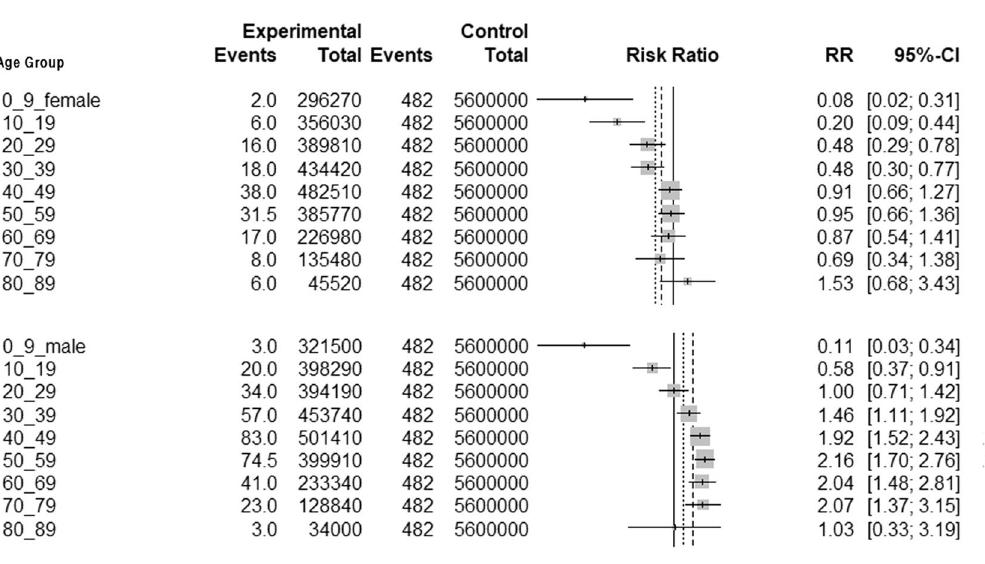
Figure 3. Risks of disease in different age groups compared to the whole population (women on top, men